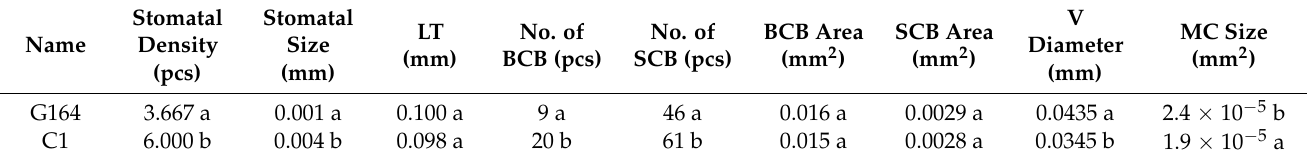
Table 1. Differences in leaf tissue structure of rice germplasm resources of different photosynthetic efficiencies.